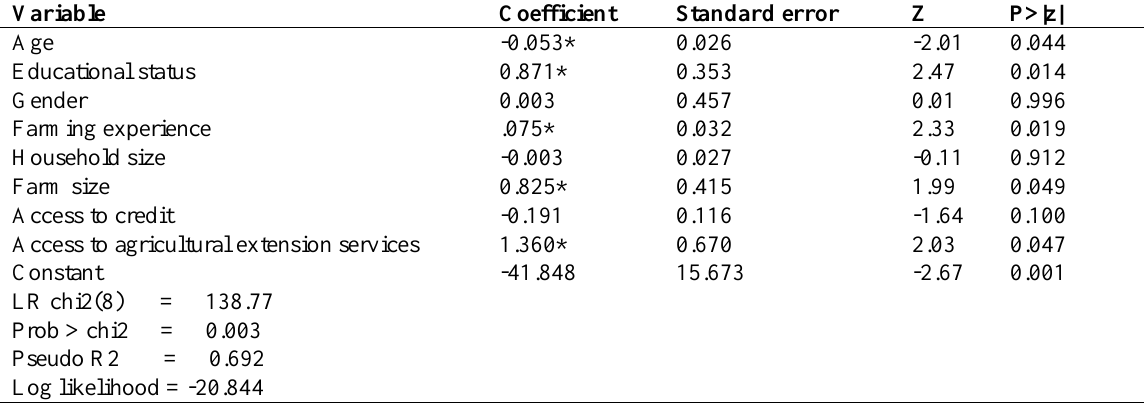
Table 6: Factors influencing adaptation to climate change by the respondents.